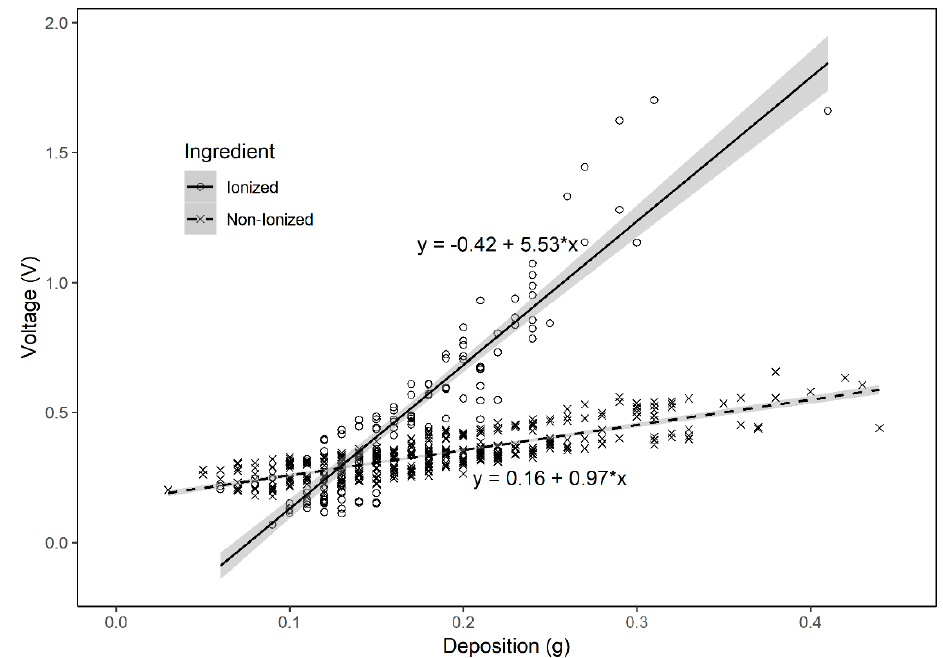
Figure 5. Linear regression models of the deposit data of sprays with ionized and non-ionized ingredients. The shadow area represents the standard error of the regressed linear models (ionized: R 2 = 0.837, non-ionized: R 2 = 0.882,).